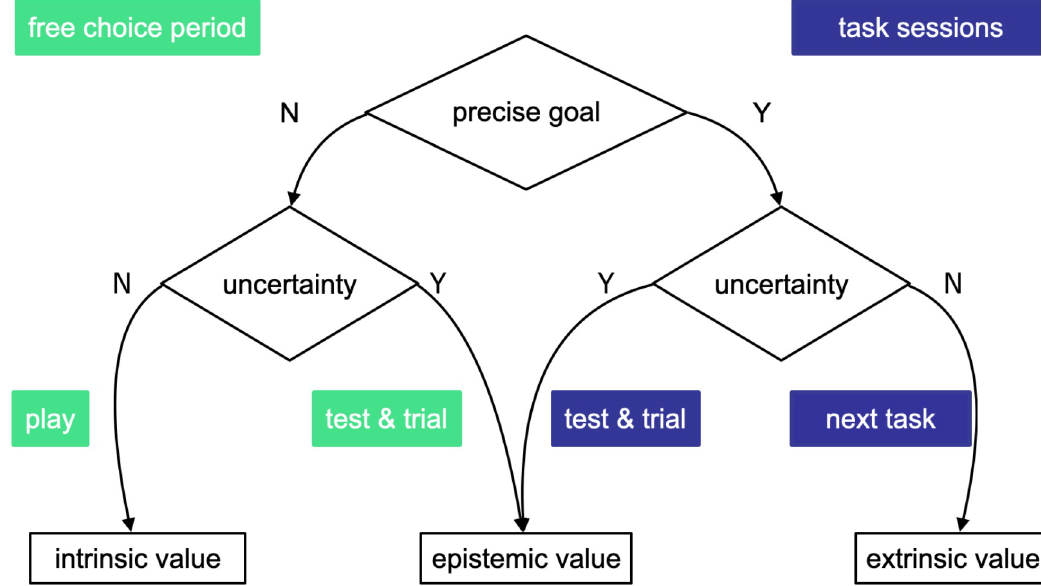
Fig 17. Revised model of action selection. Even in the absence of precise goals, uncertainty perceived during previous interactions should affect action selection.